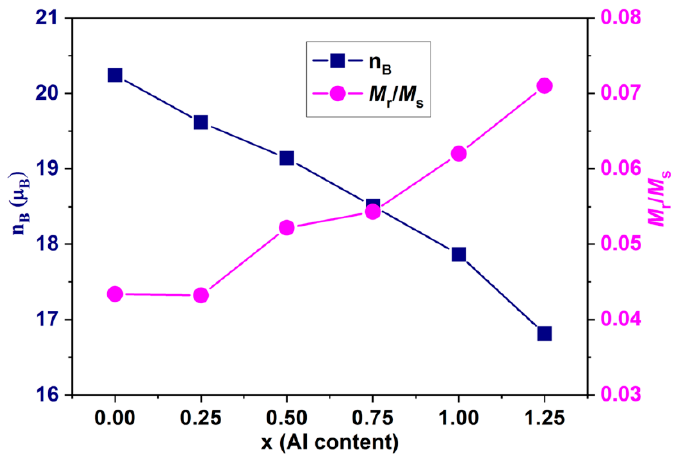
Figure 9. Effects of Al content (x) on the magneton number ( n B ) and M r / M s for the W-type SrYb hexaferrite Sr 0.85 Yb 0.15 Zn 1.5 Co 0.5 Al x Fe 16-x O 27 .